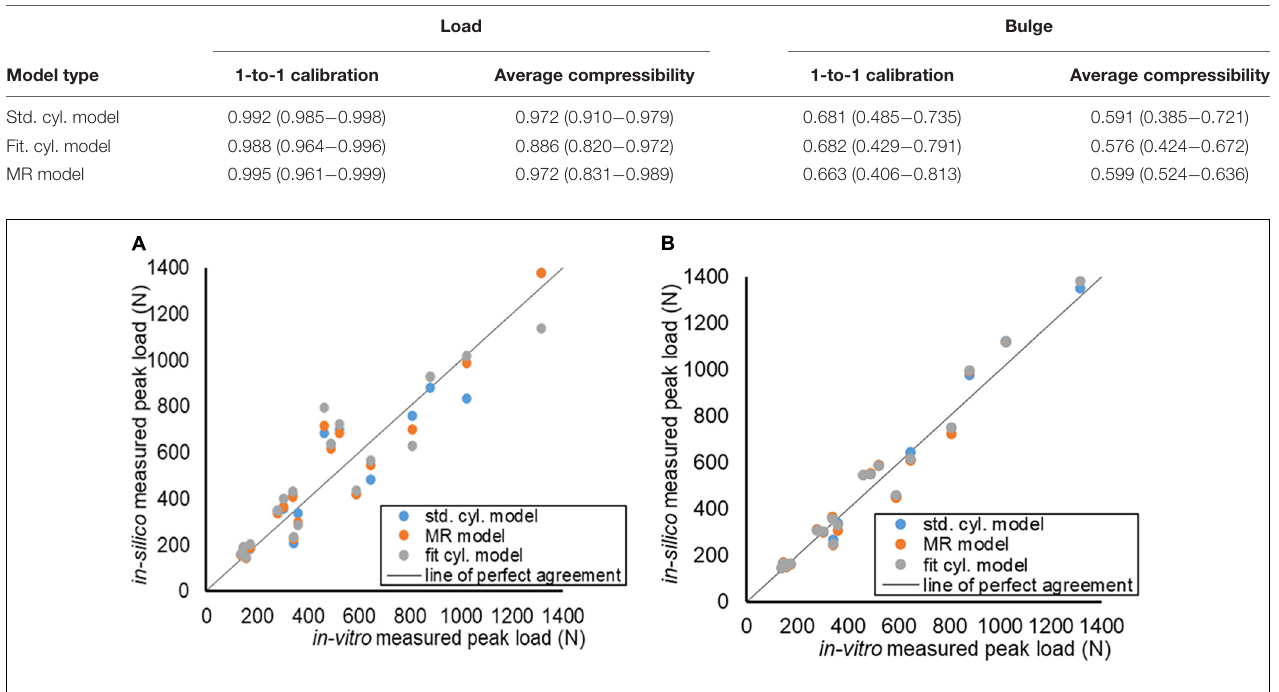
TABLE 3 | Concordance coefficients (CCC with 95% confidence interval in brackets) across all specimens and all displacements steps of in silico load and markers bulge (disregarding markers within the lowest 10 percentile of experimental bulge).